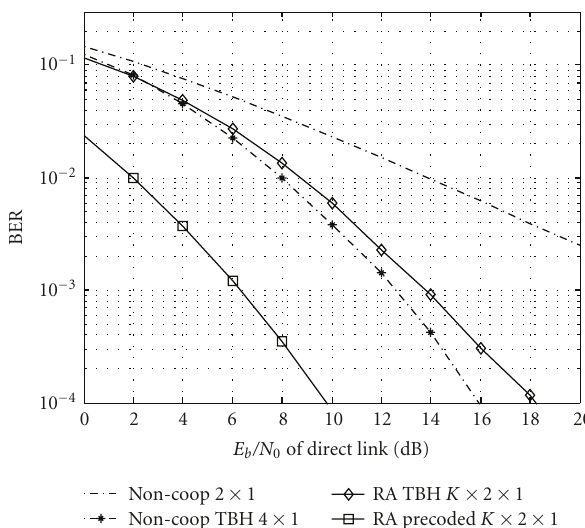
Figure 14: BER of cooperative systems with 2 antennas per relay and of reference systems for Scenario 2.